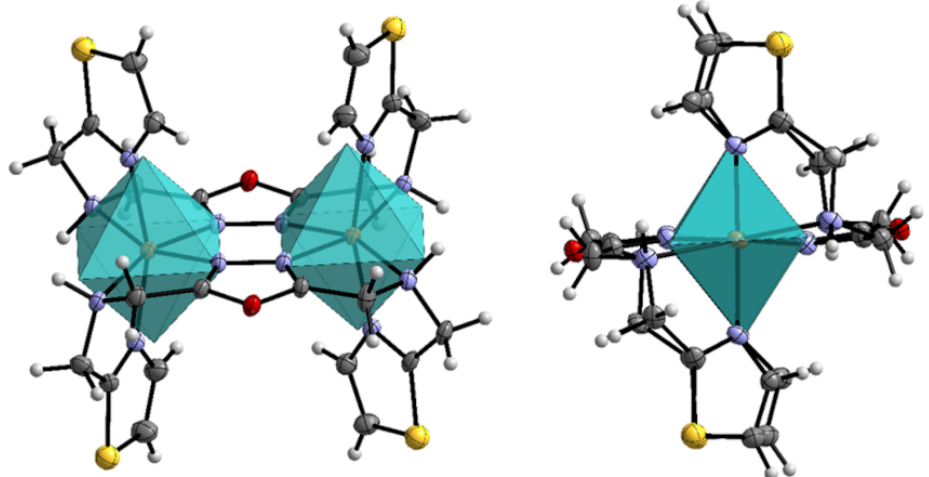
Figure 3. Molecular structure of 3 and its ideal coordination octahedron with front view ( left ) and view onto the Fe-Fe axis ( right ), calculated with SHAPE [55]. Color scheme: dark grey—C, grey—H, violet—N, red—O, yellow—S, orange—Fe. ORTEP representation with atomic displacement parame- ters set to 50%